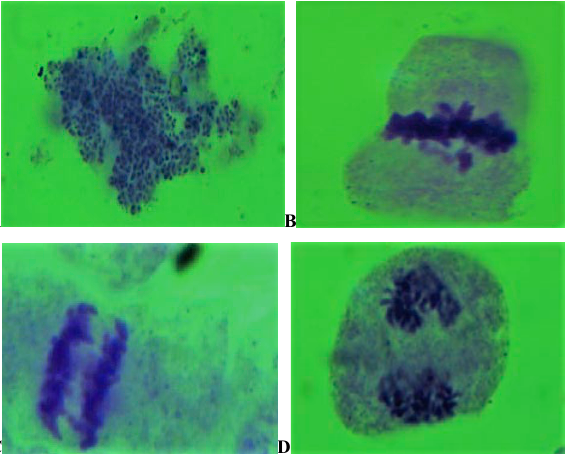
Figure 1. Some chromosomal aberrations identified in meristematic cells of Ocimum basilicum L. exposed to Cd and Zn: pyknosis (A); sticky metaphase whit laggards chromosomes (B); bridges (C); dis- turbed telophase whit pyknotic chromosomes